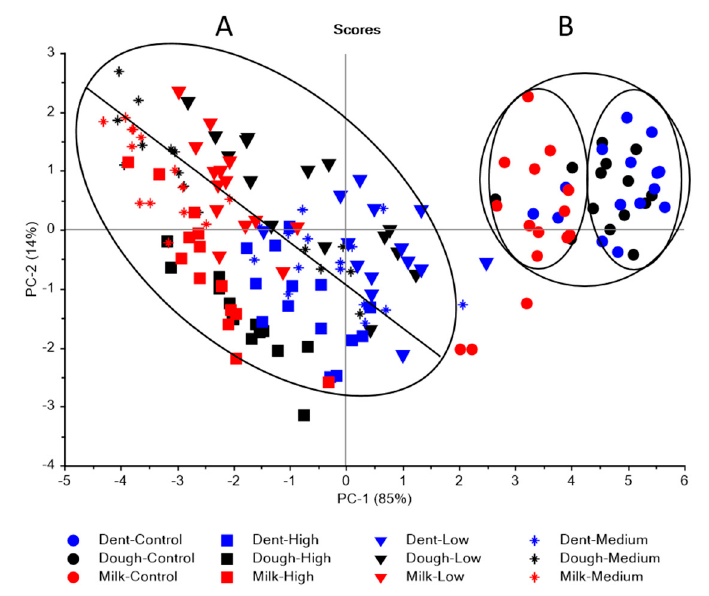
Figure 5. PCA scores plot for raw NIR spectra of inoculated kernel stage categories in stage-dose classifications with samples divided into 2 main clusters (A and B).